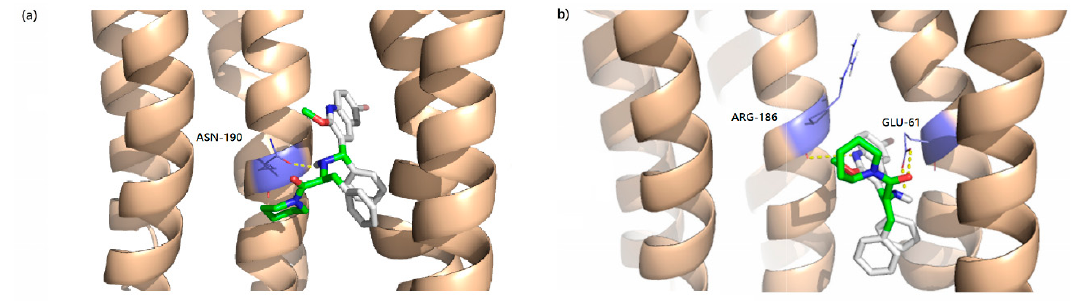
Figure 6. The ATPase active site in complex with compound 1 ( a ) and 1* ( b ).